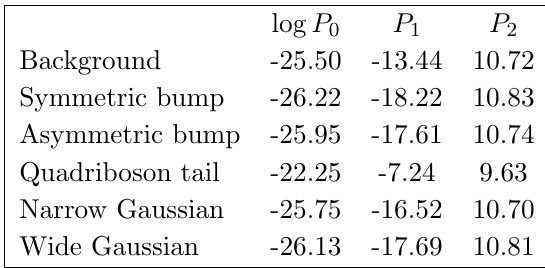
Table 2 . Background-only best-(cid:12)t parameters for the functional form in eq. (3.1) for the input background and with various injected signals, for the Asimov